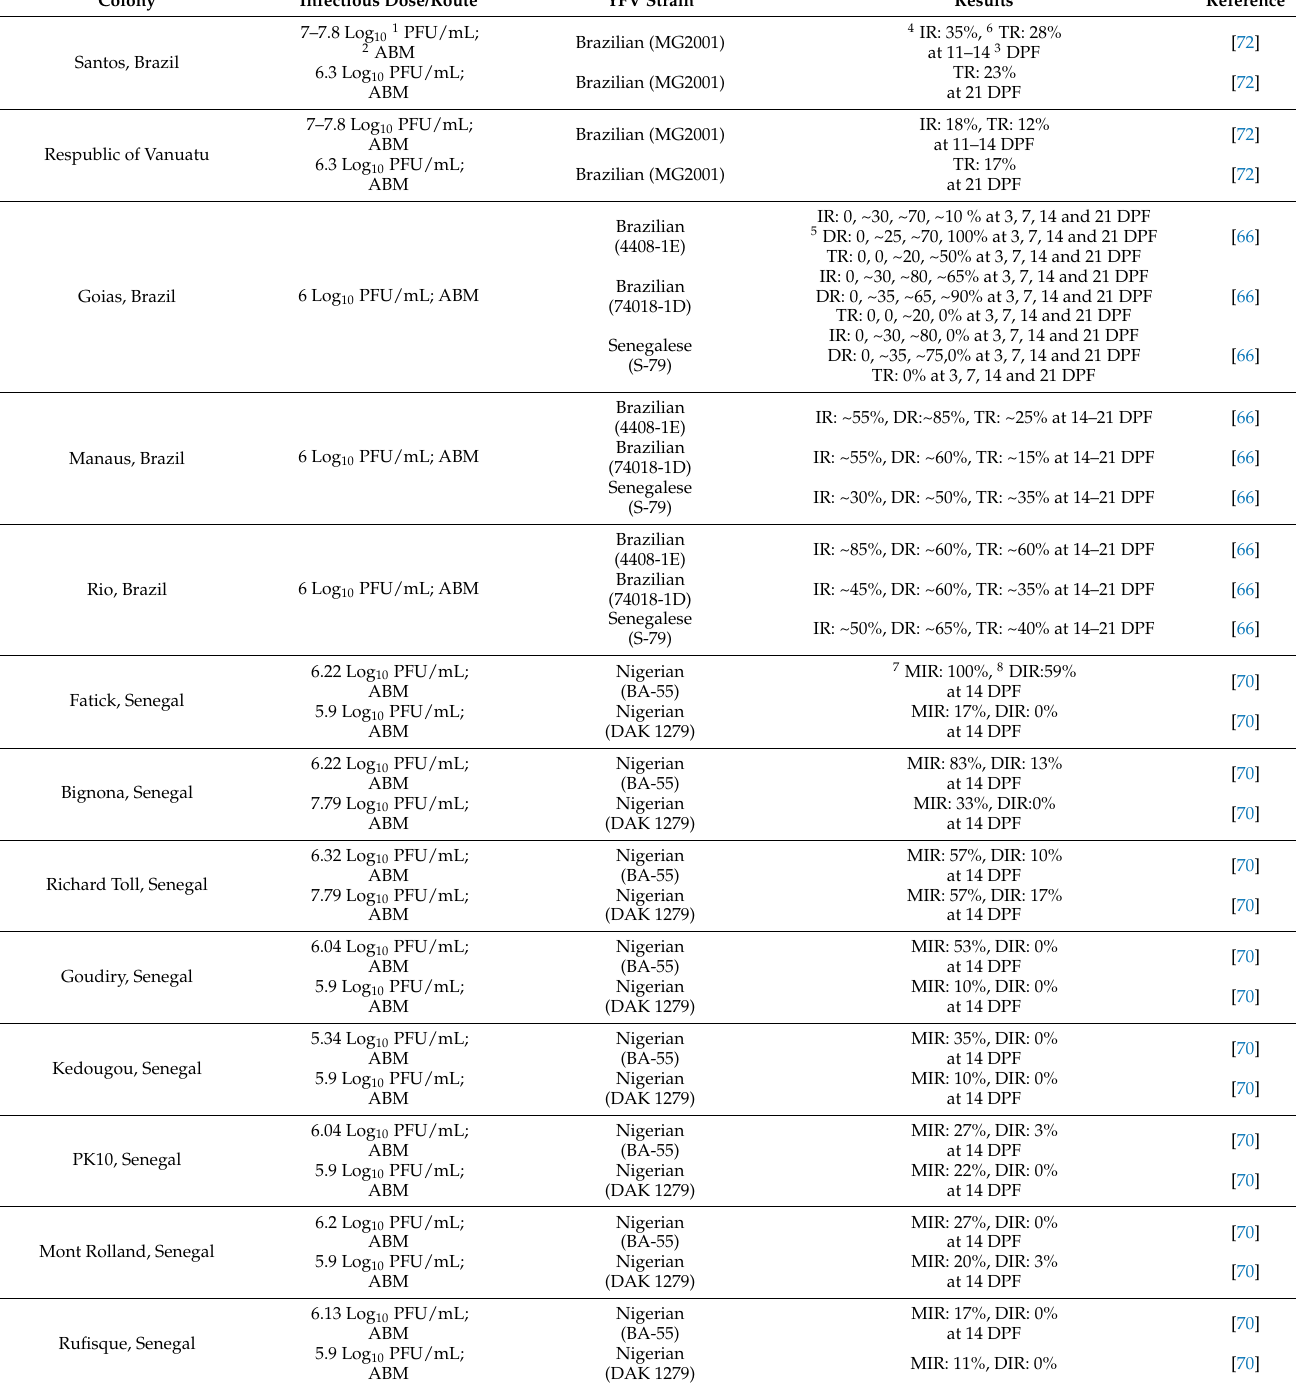
Table 4. Vector competence studies in Ae. aegypti